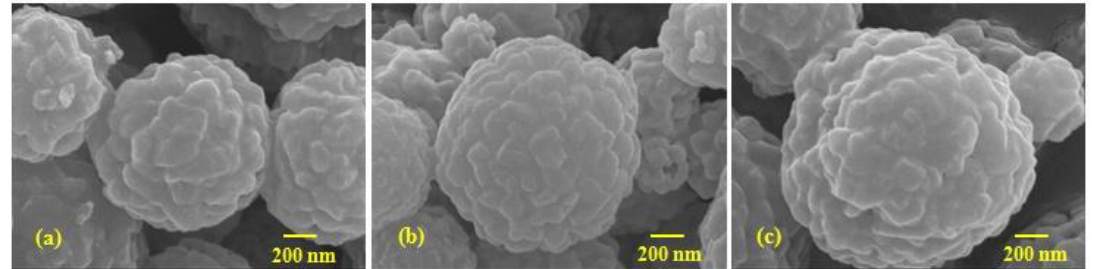
Figure 2. ( a ) X-ray diffraction (XRD) patterns for a theoretical pattern, Pluronic F-127 (F127), Pluronic P-123 (P123), and Trition X-114 (TX114) and N 2 adsorption-desorption isotherms and the pore-size distribution plots (insert) for ( b ) TX114; ( c ) P123; and ( d ) F127.